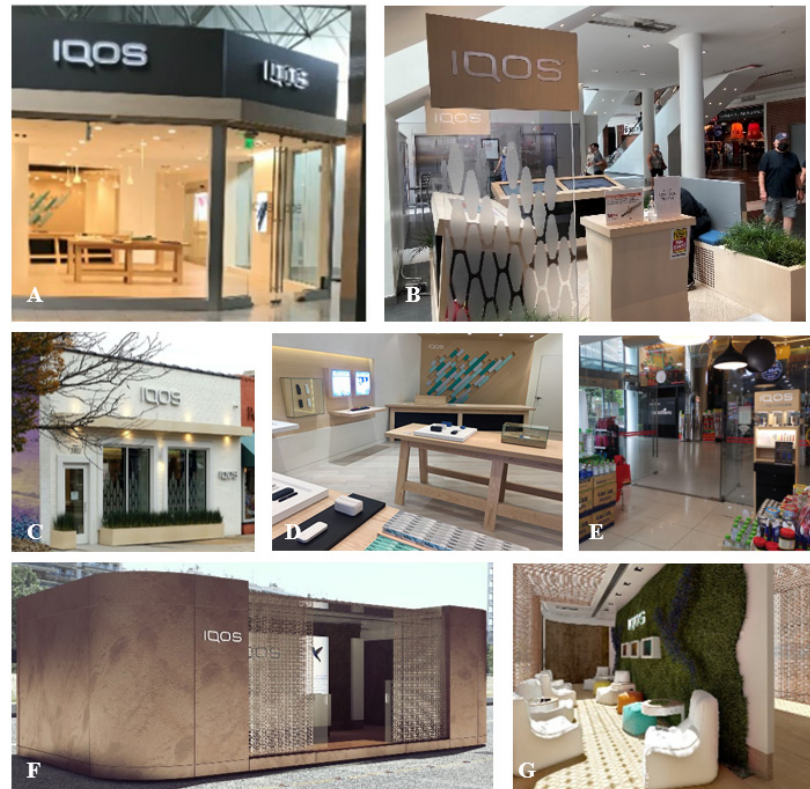
Figure 1. Types of IQOS points-of-sale. Notes: ( A ): Specialty Store, Lenox Mall, Atlanta, Georgia, US, Fall 2019 [37]; ( B ): Kiosk, Pentagon City Mall, Arlington, Virginia, US, Summer 2021 (photo by authors); ( C , D ): Specialty Store, Richmond, Virginia, US, Spring 2021 (photo by authors); ( E ): Corner, Kuala Lumpur, Malaysia, Fall 2019 [49]; ( F , G ): Pop-up, Thessaloniki, Greece, Summer 2018 [50].